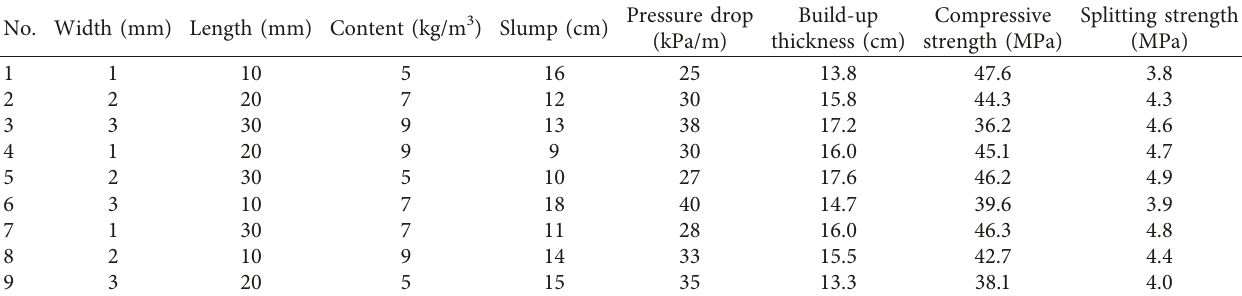
Figure 7. The optimal PET fiber parameters for minimiza- tion of pressure drop were 1 mm width, 30 mm length, and 5 kg/m 3 content.